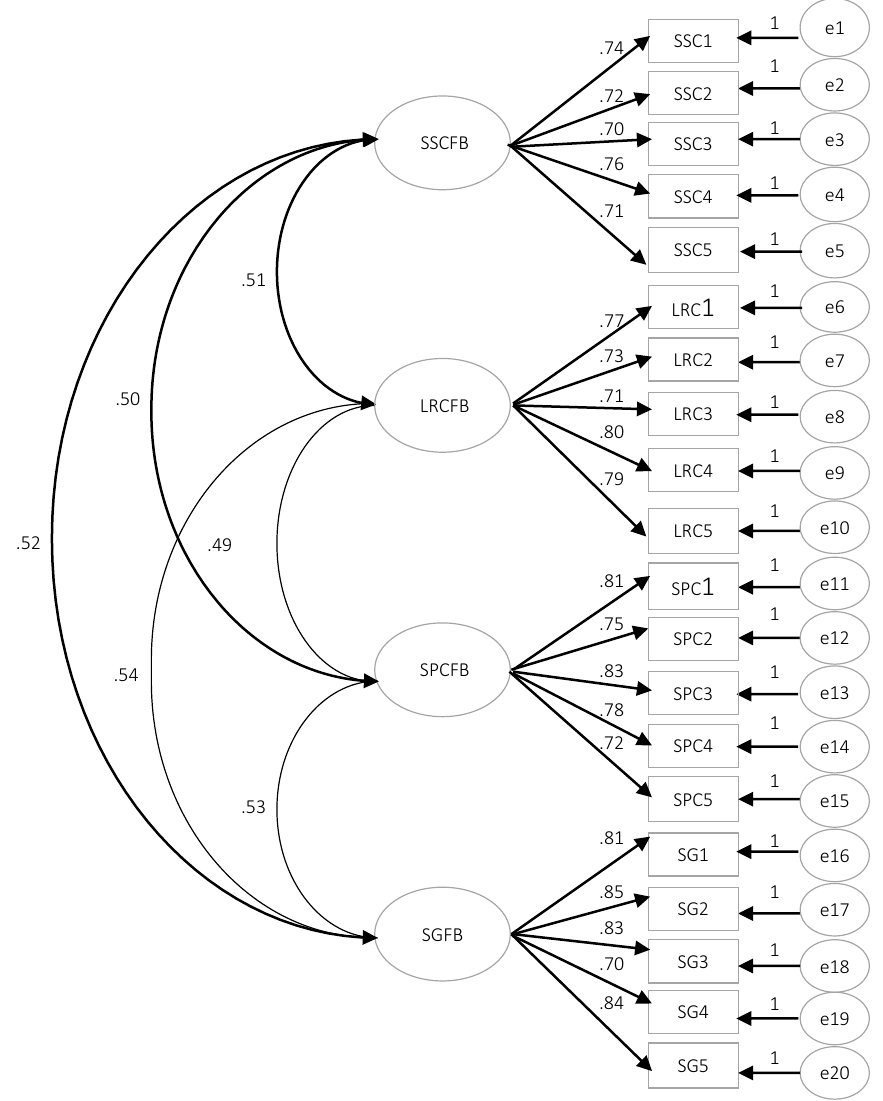
Figure 1. Path analysis of the questionnaire measurement